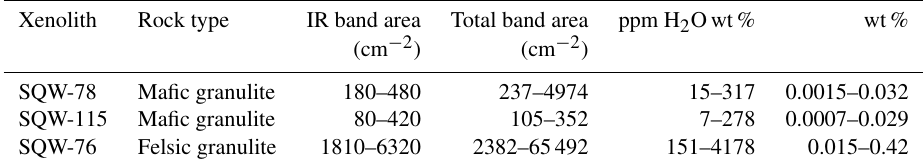
Table 2. H 2 O concentrations in